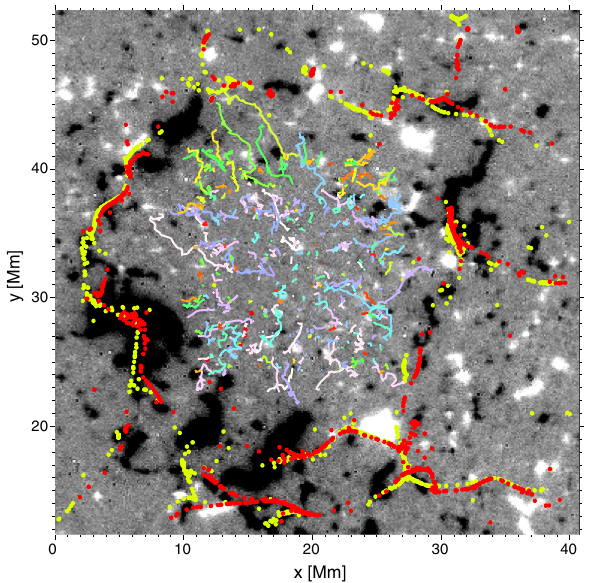
Fig. 15 Trajectories of 375 IN magnetic patches within a supergranular cell. The observations were taken by the Hinode NFI in the framework of HOP 151. Different magnetic elements are shown with different colors. The border of the supergranular cell is marked with red and yellow corks as derived through local correlation tracking of continuum intensity and LOS velocity structures, respectively. Image reproduced with permission from Goši´c